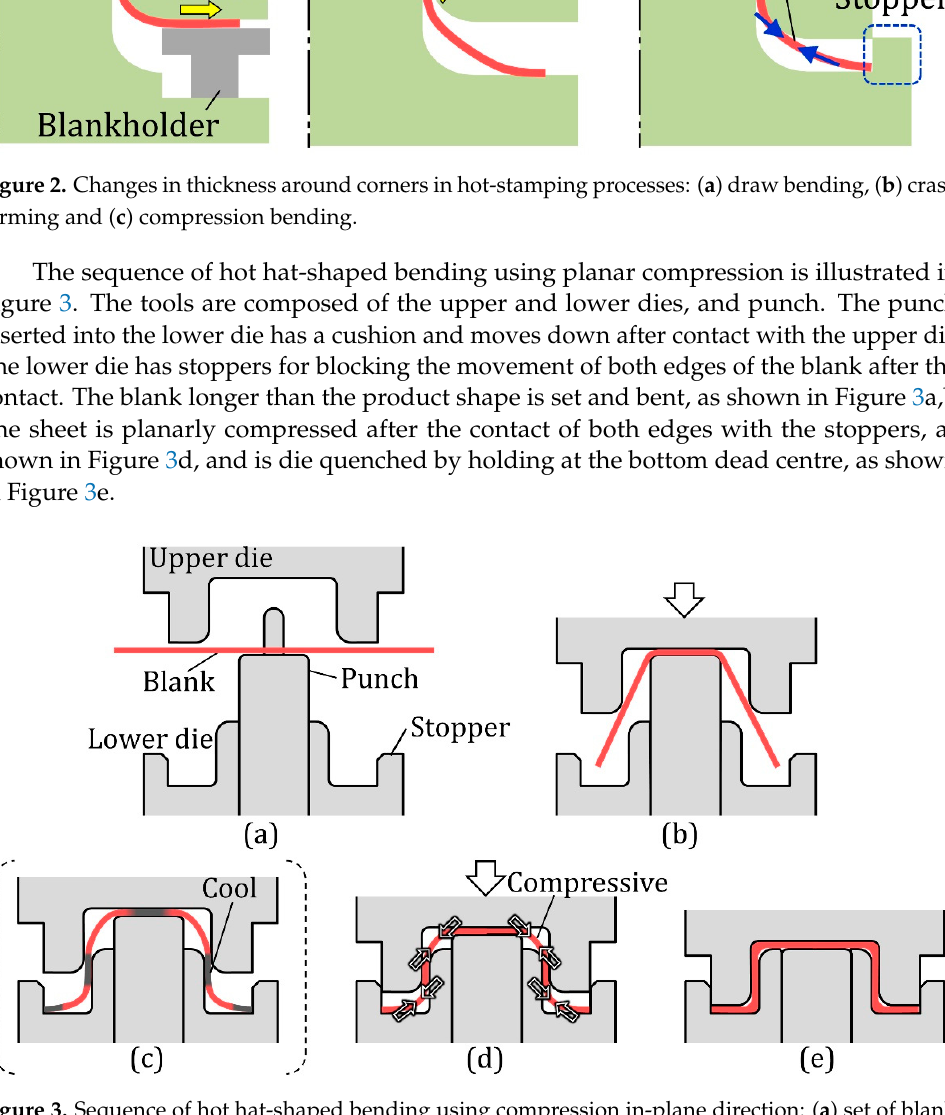
Figure 3. Sequence of hot hat-shaped bending using compression in-plane direction: ( a ) set of blank, ( b ) bending, ( c ) partial cooling for 1.5 s, ( d ) thickening of corner and ( e ) die quenching.